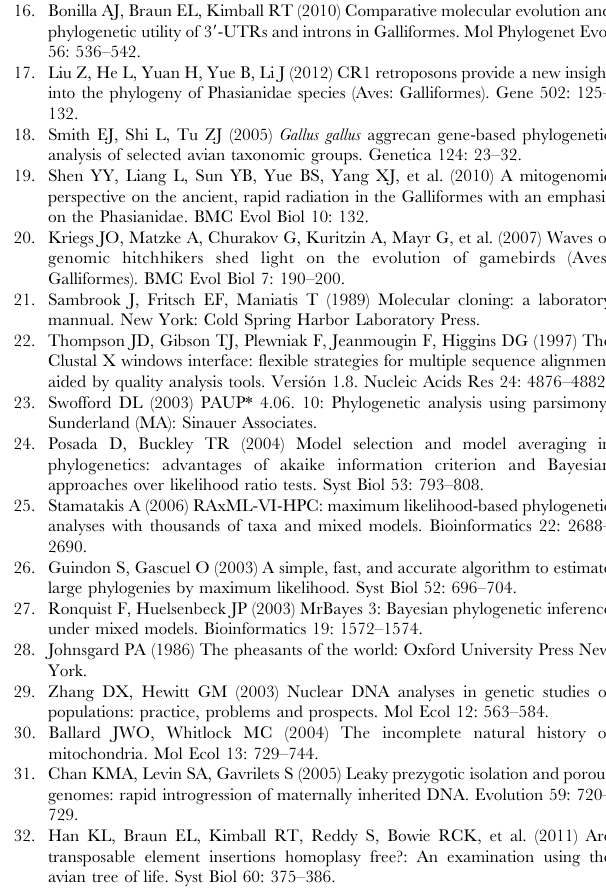
Figure S1 Bayesian inference analyses of 13 mt genes that excluding the 3 rd codon position. (TIF) Figure S2 Bayesian inference analyses of 13 mt genes that recoding the 3 rd codon position nucleotides to two- state categories, R (purine) and Y (pyrimidine). Figure S3 Bayesian inference analyses of 13 mt genes that recoding the 1 st and the 3 rd codon position nucleotides to two-state categories, R (purine) and Y (pyrimidine). Figure S4 Bayesian inference analyses of individual mt genes and control region (CR). Each run was conducted with 5,000,000 generations and sampled every 100 generations. Bayesian Posterior Probabilities . 70% were indicated on the